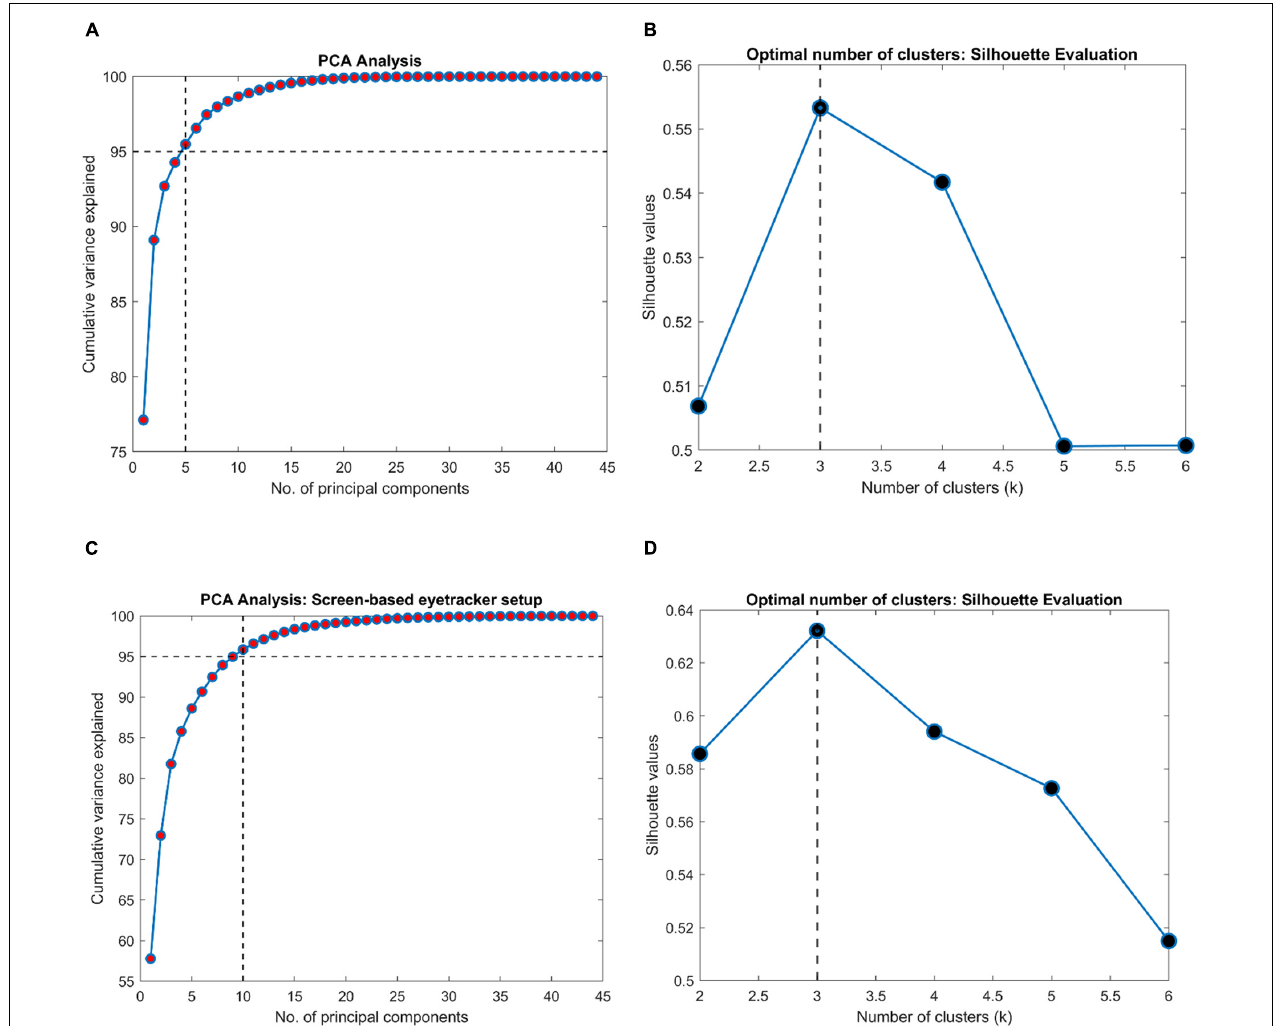
FIGURE 3 | Results of clustering analysis in the VR and the screen-based eye tracker setup. (A,C) PCA analysis on the VR and the screen-based eye tracker gaze data indicating the number of components that together explained at least 95% of the variance in the STP features, respectively. A k -means clustering was then performed on this PCA-reduced data. (B,D) Evaluation of the optimal number of clusters for the VR and screen-based eye tracker setup using the Silhouette